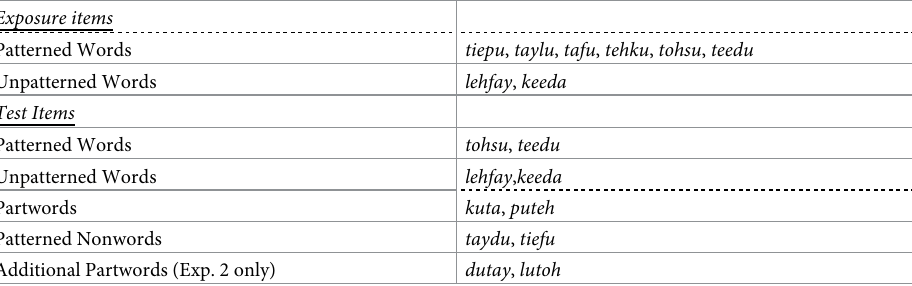
Table 1. Stimuli for Experiments 1 and